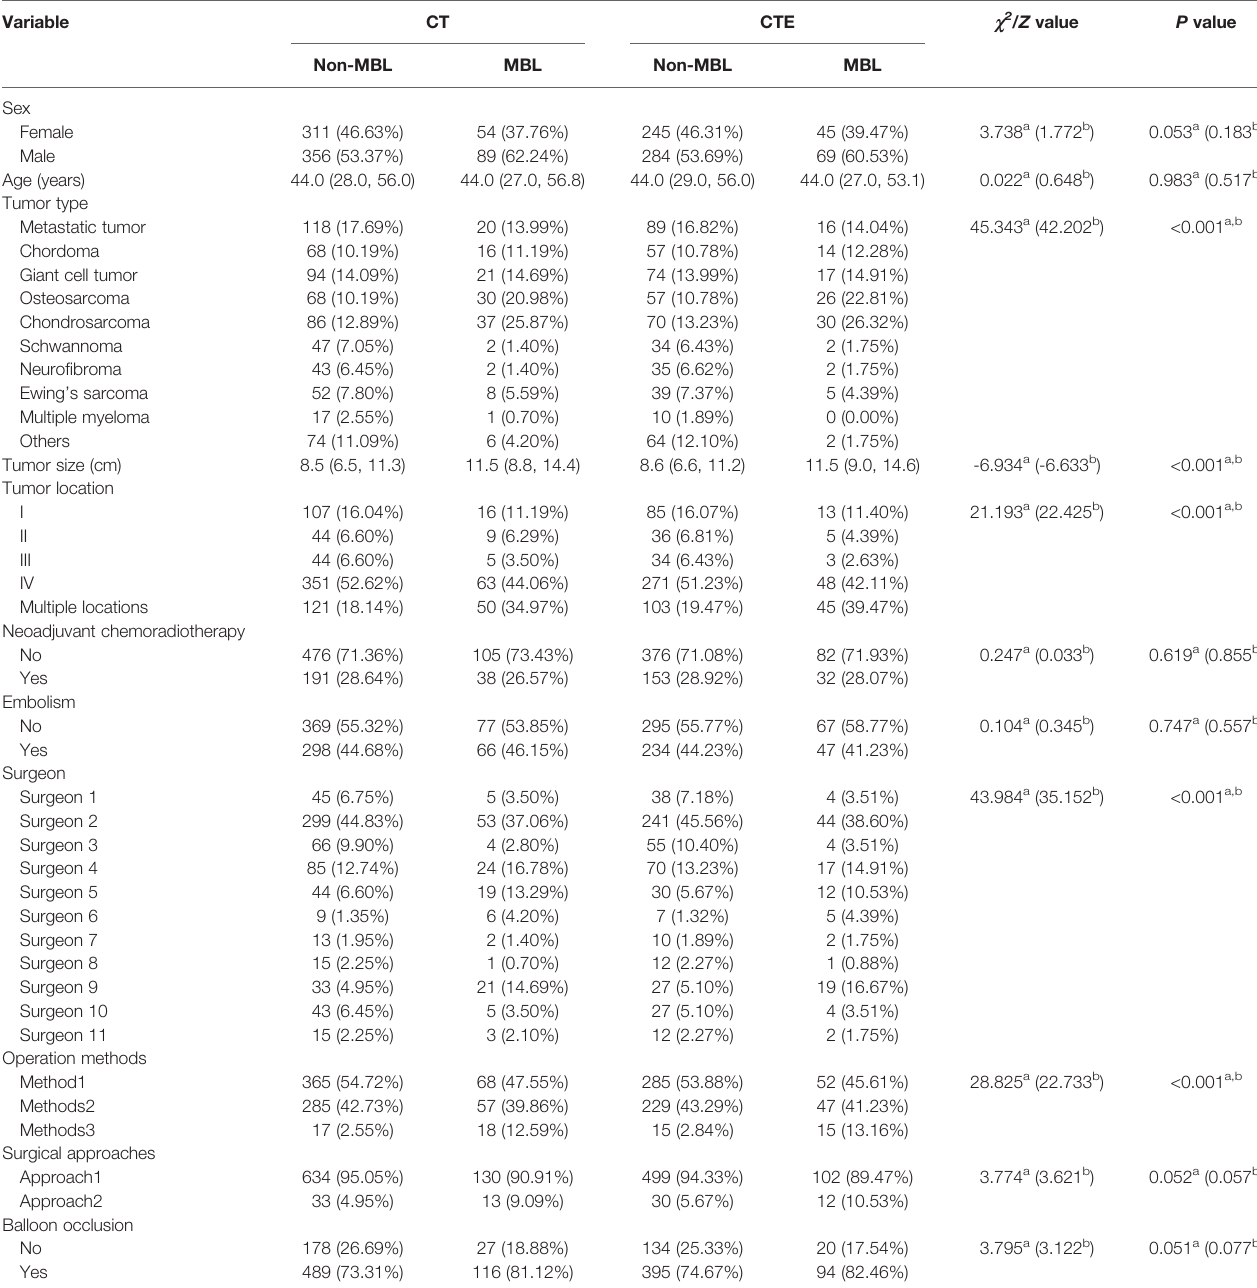
TABLE 1 | Clinical characteristics of